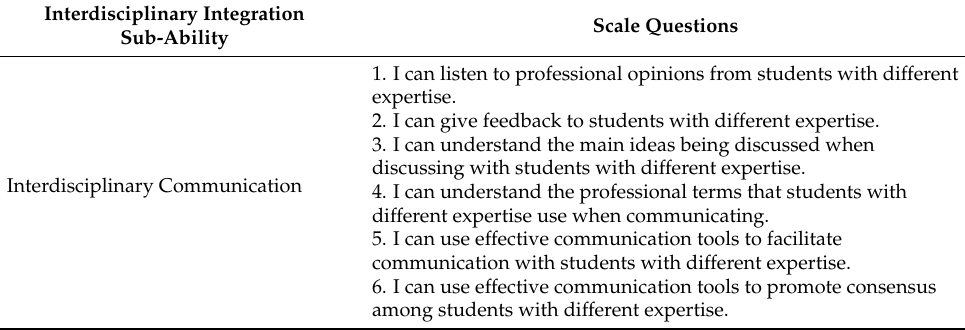
Table A1. Core Interdisciplinary Integration Ability Scale